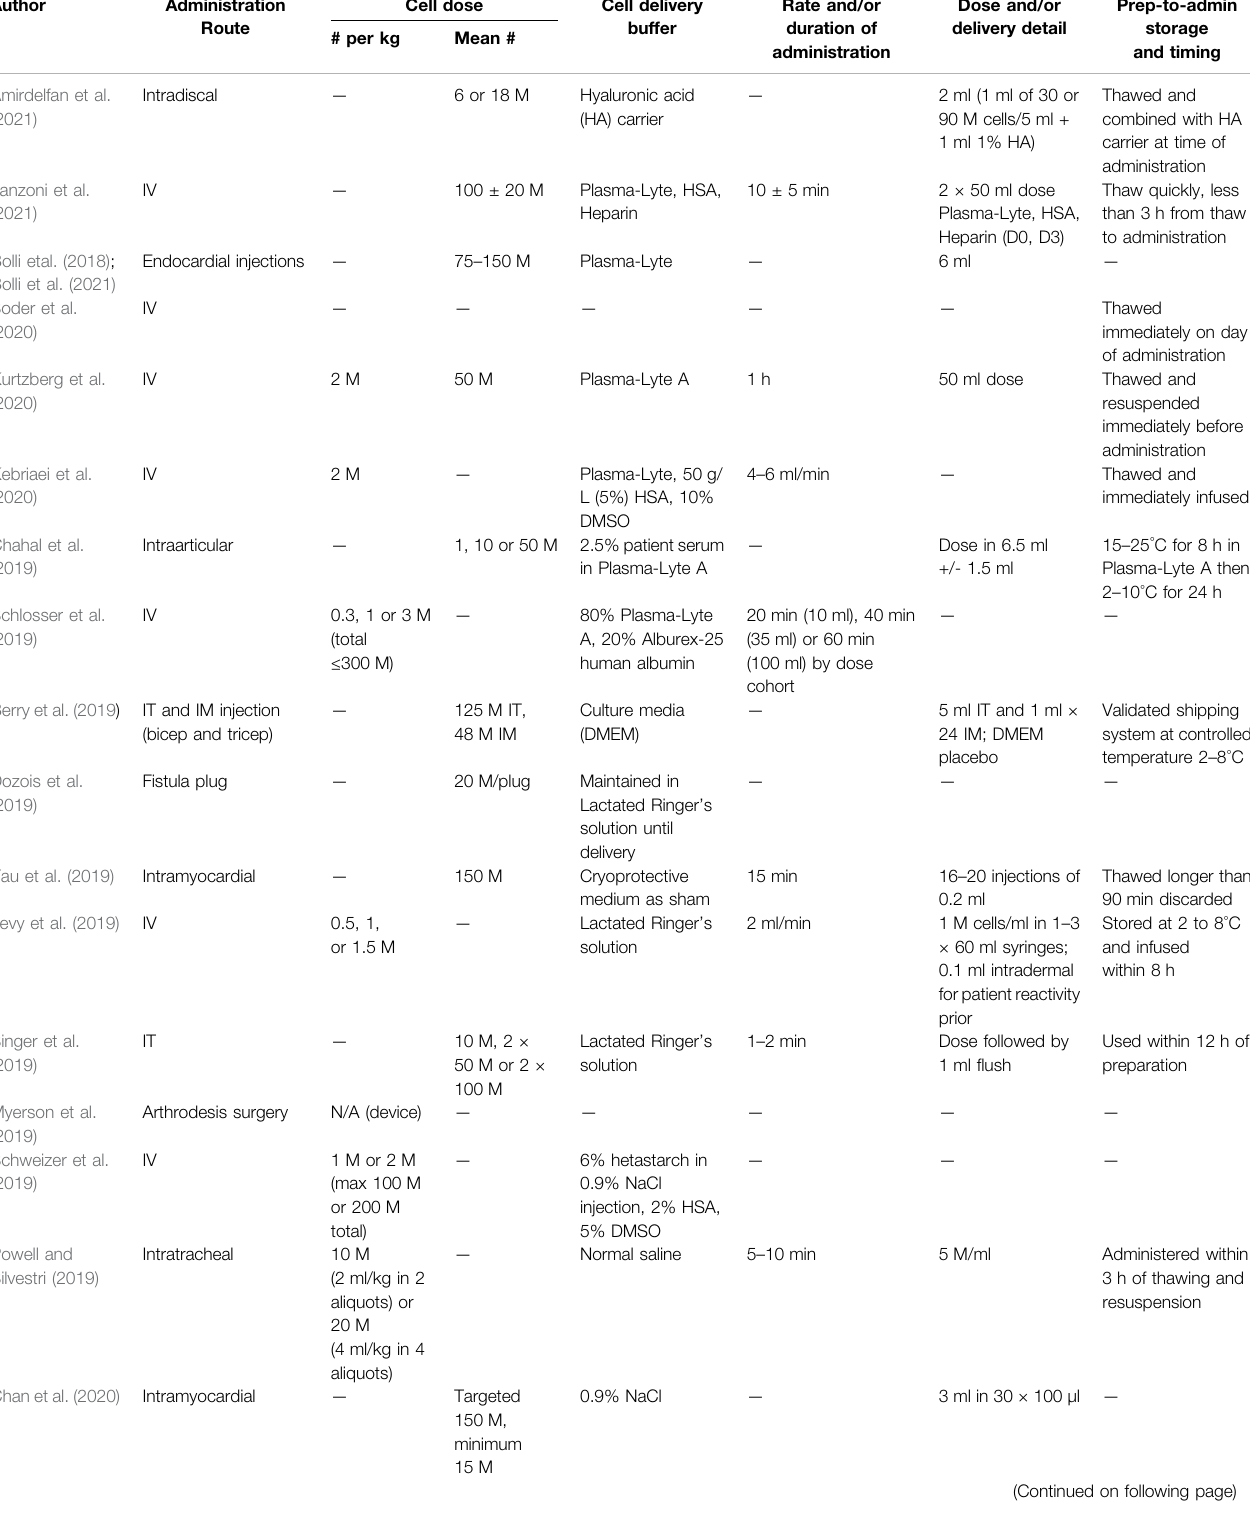
TABLE 1 | Clinical trial publications inconsistently report details relevant to MSC dose preparation and bedside handling. Dashed lines represent unreported